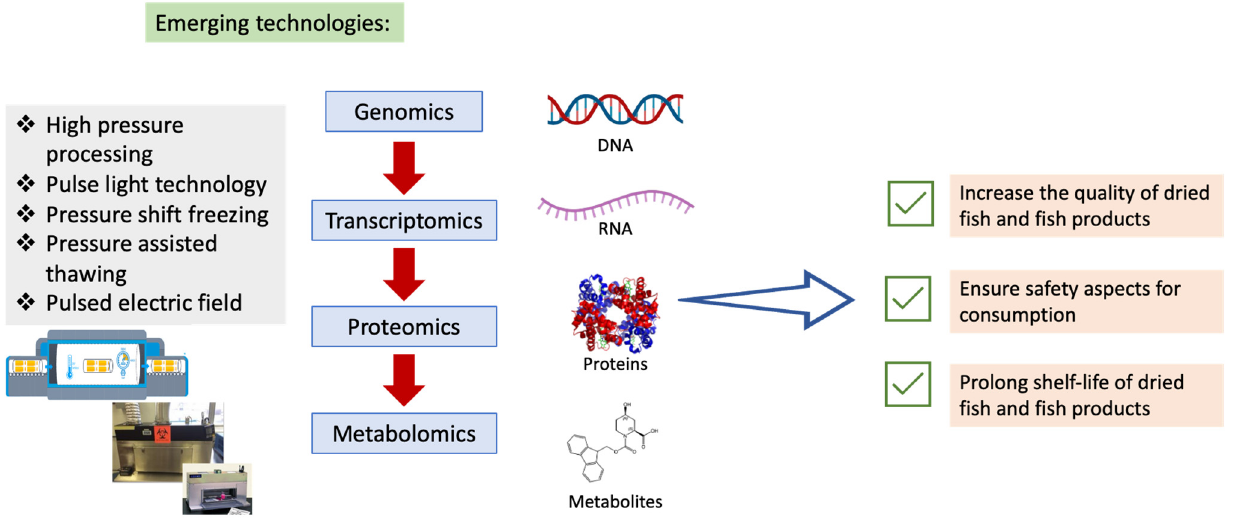
Figure 7. Emerging technologies in enhancing the quality of dried fish products.